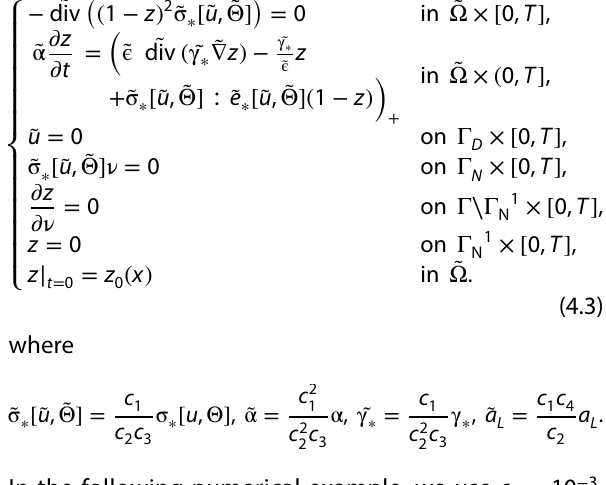
Table 3 Typical material properties of solder and numerical parameters